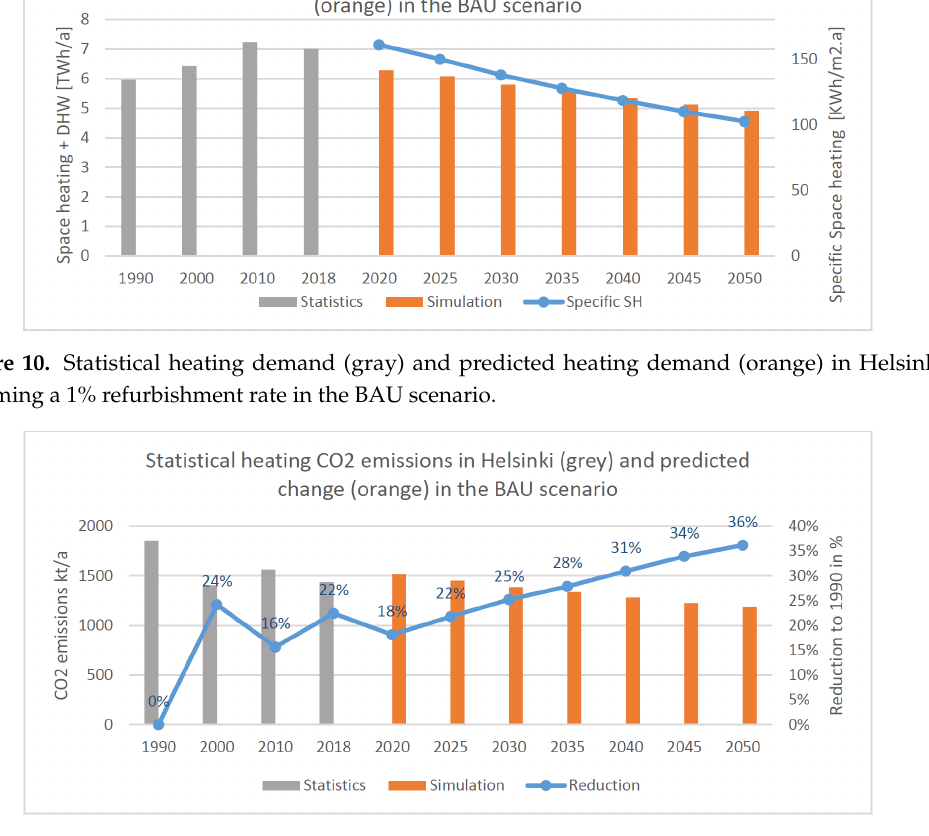
Figure 11. Statistical (gray) and predicted (orange) CO 2 emissions in Helsinki with a 1% refurbishment rate, using the 2019 CO 2 emission factor for district heating.